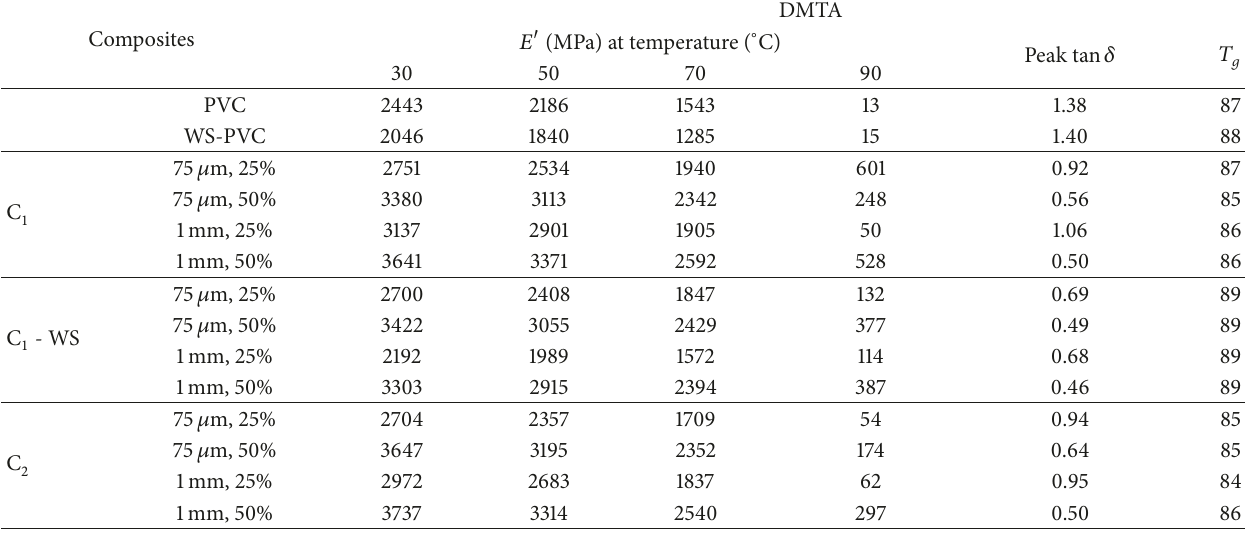
Table 3: DMTA properties of composites.